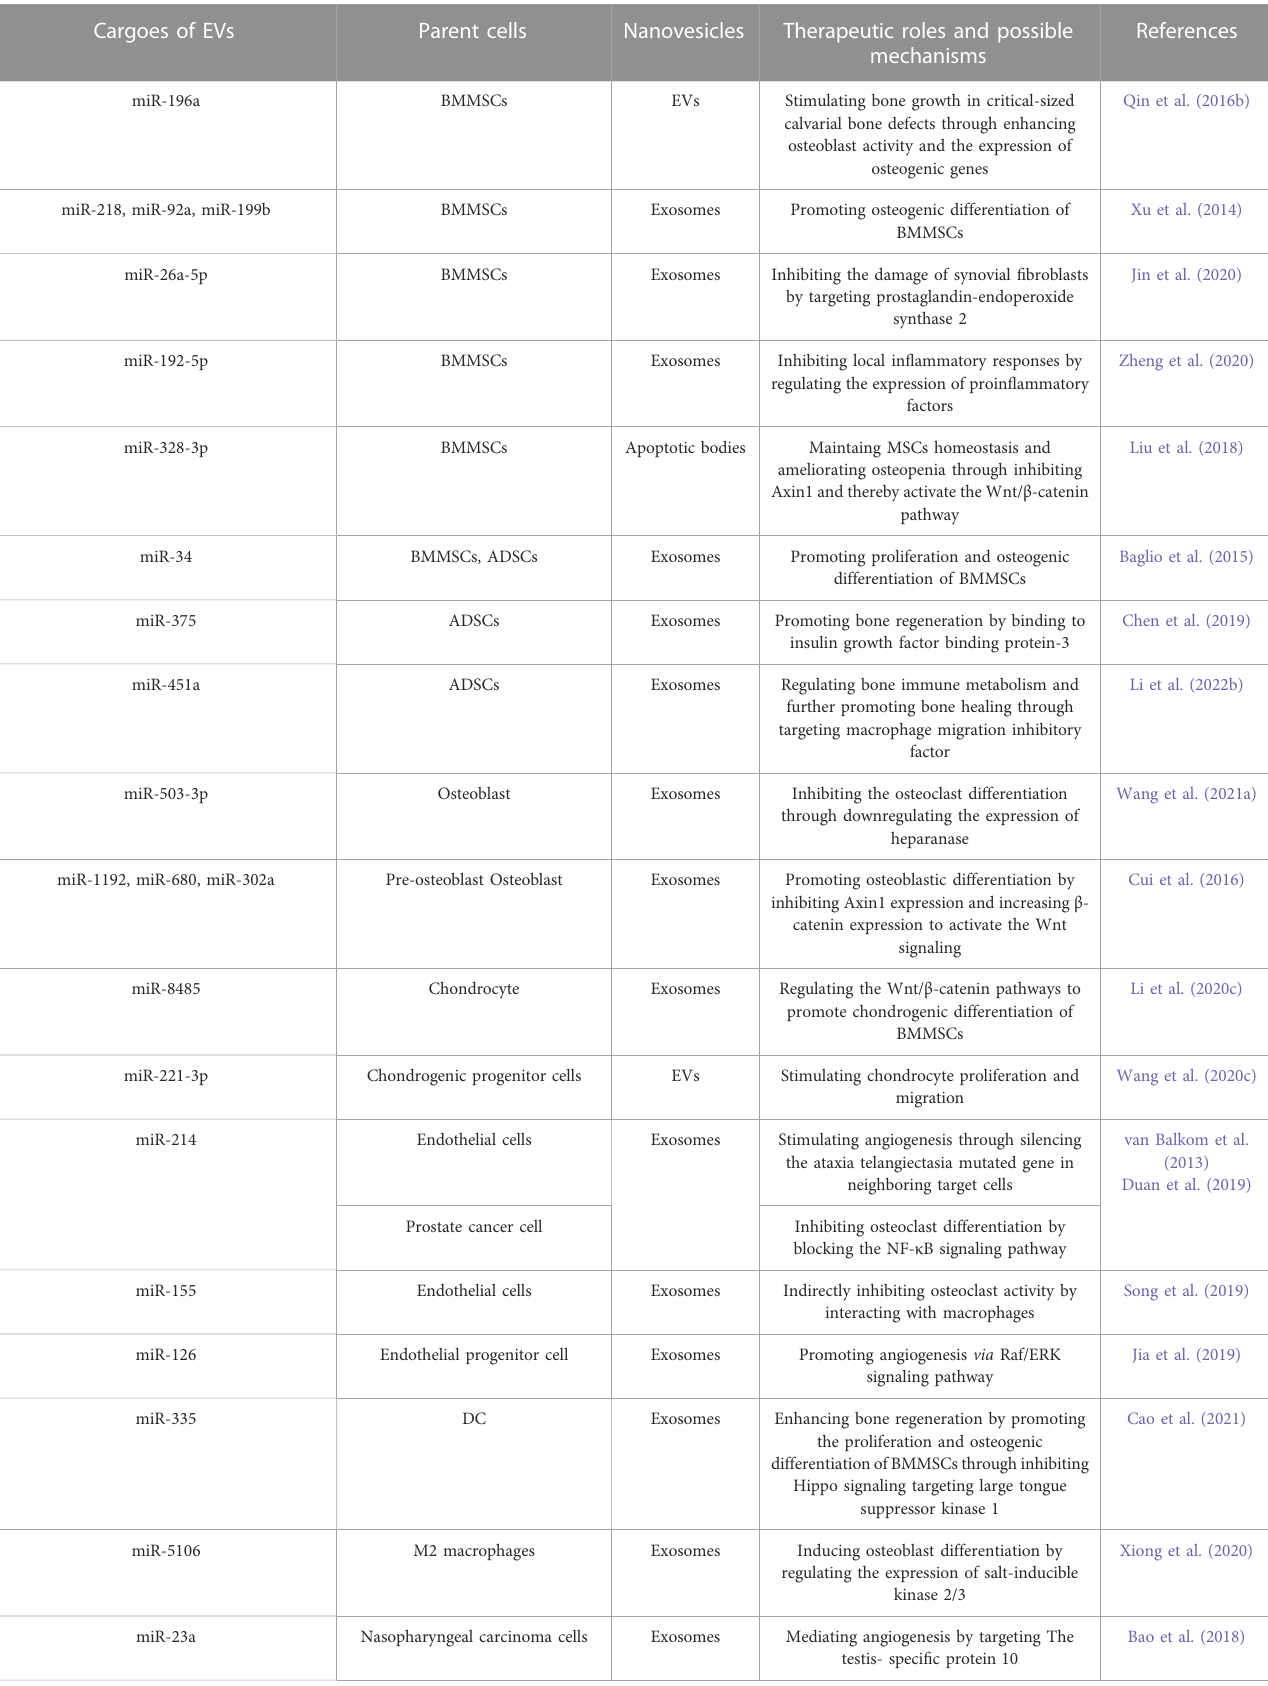
TABLE 2 Therapeutic roles and possible mechanisms of certain miRNAs and proteins of EVs in critical-size bone defects repair. Cargoes of